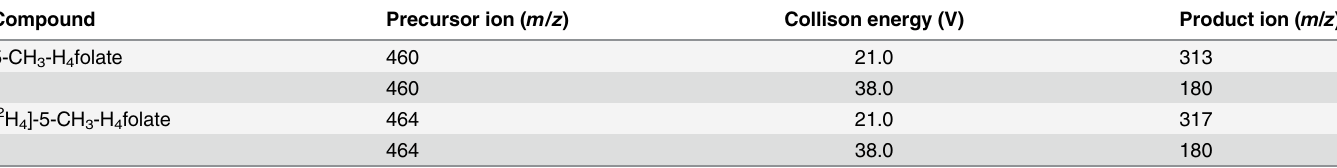
Table 1. Multiple-reaction monitoring transitions of 5-CH 3 -H 4 folate.